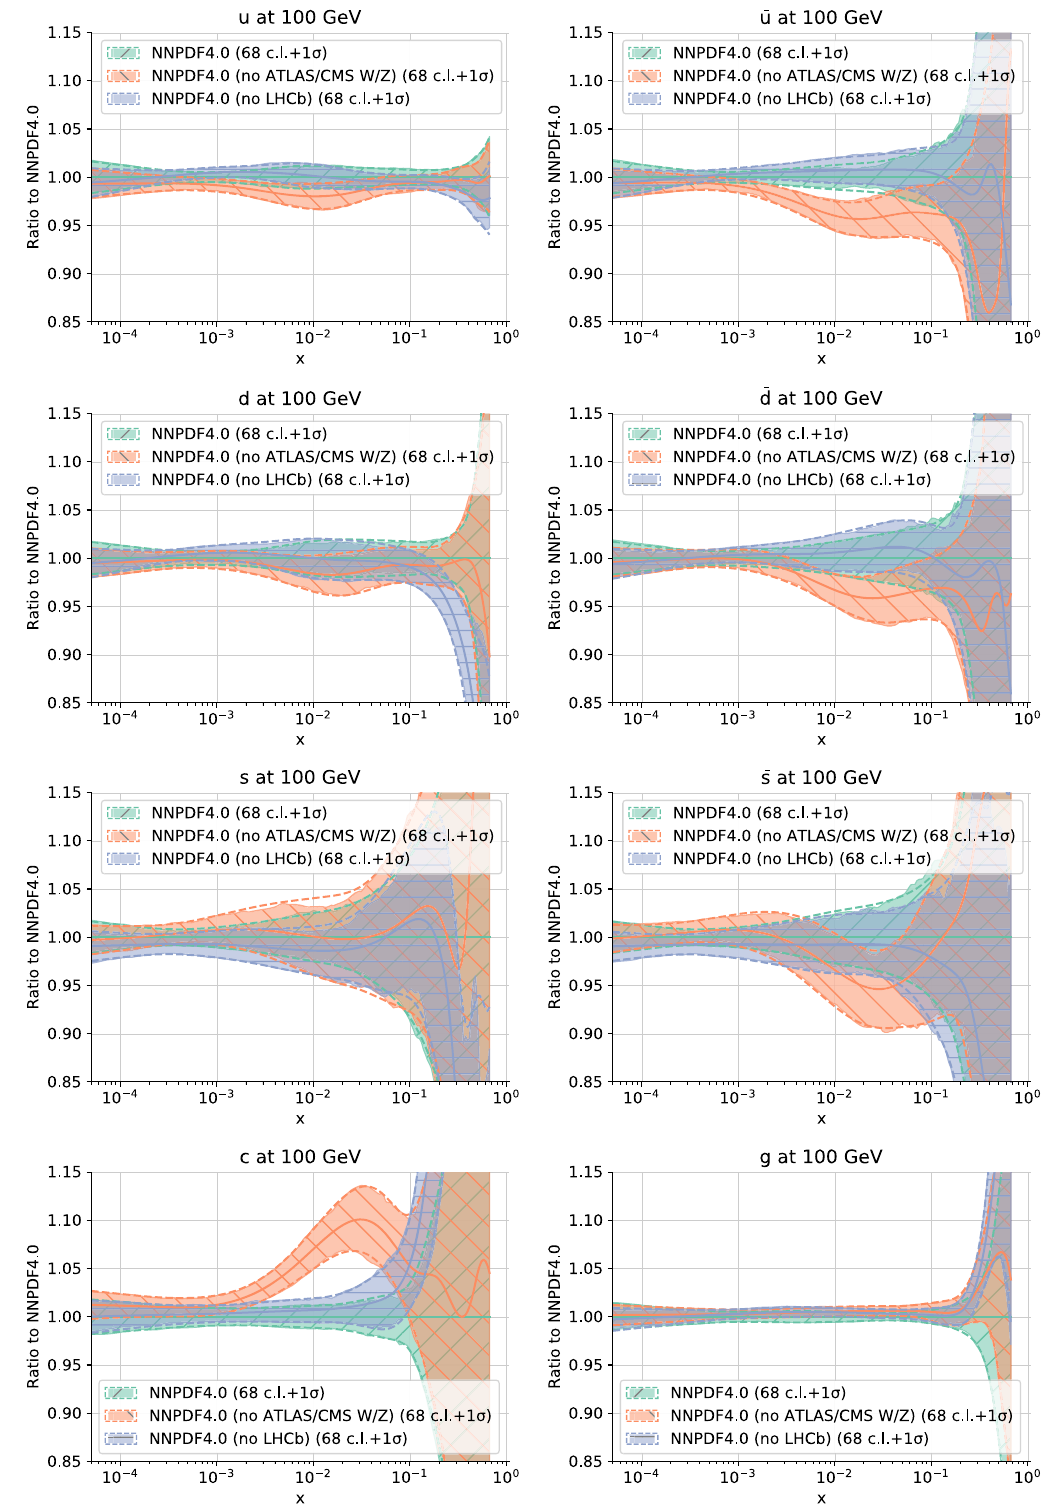
Fig. 35 Same as Fig. 31 comparing the baseline to PDFs determined removing either all of the ATLAS and CMS, or all of the LHCb inclusive gauge boson production